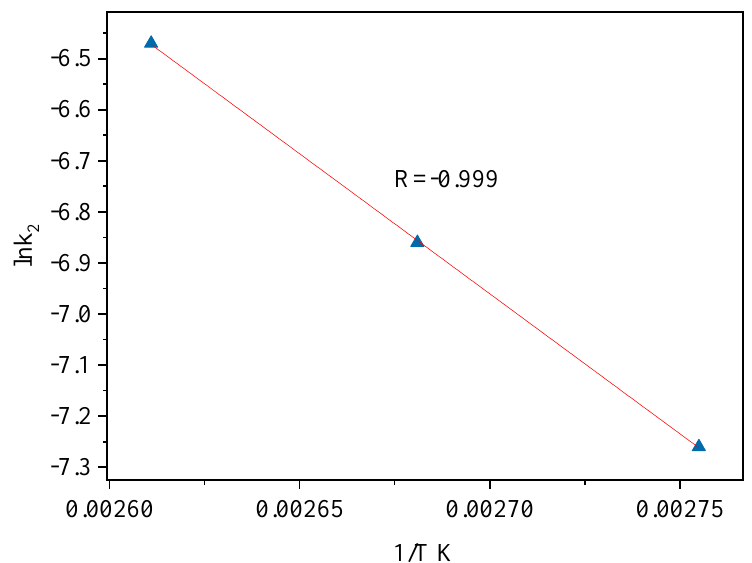
Figure 12. ln k 2 – T − 1 relationship for Co leaching.